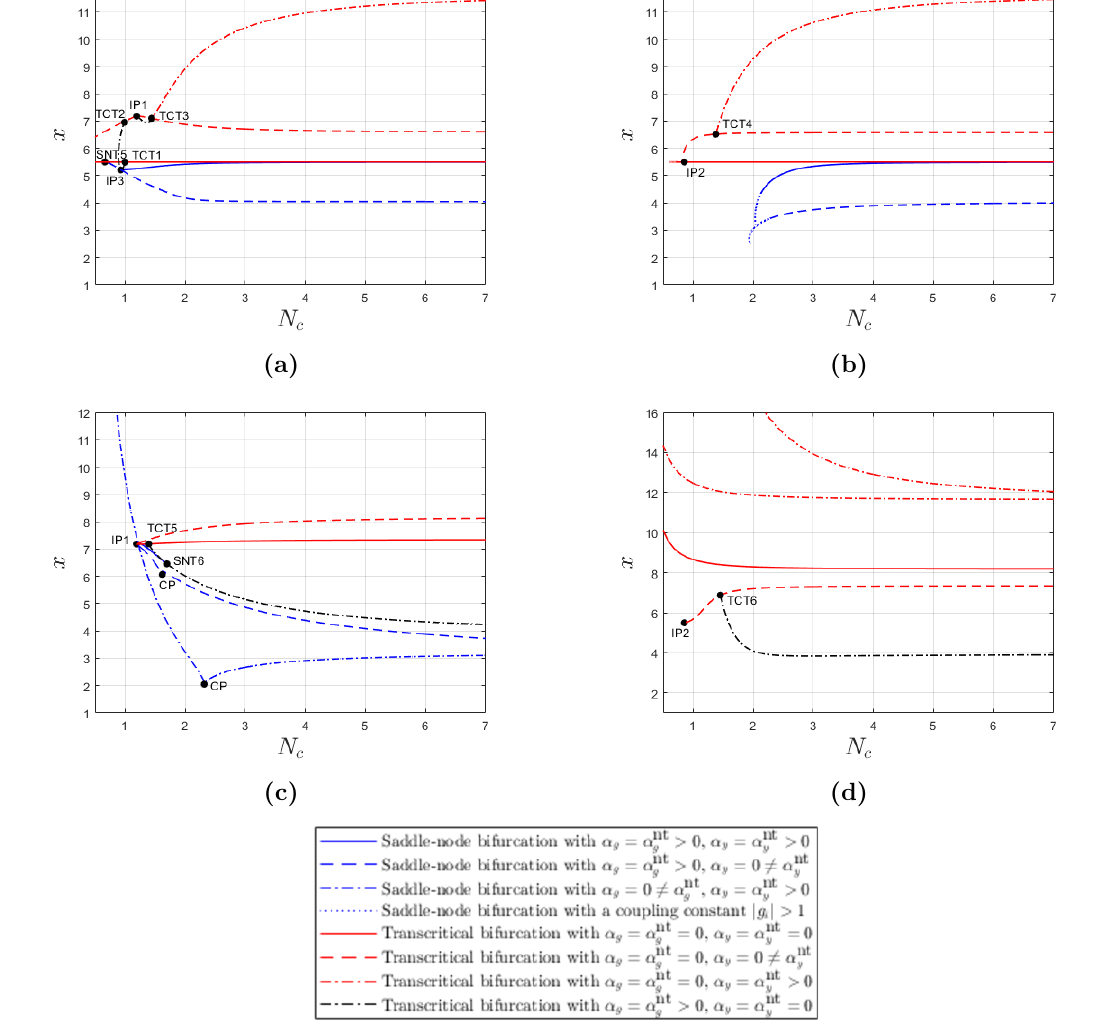
Figure 20. Bifurcations in the RG-(cid:13)ow of (3.3) in the ( N Saddle-Node-Transcritical bifurcation. TCT: Transcritical-Transcritical bifurcation. IP: degenerate bifurcation